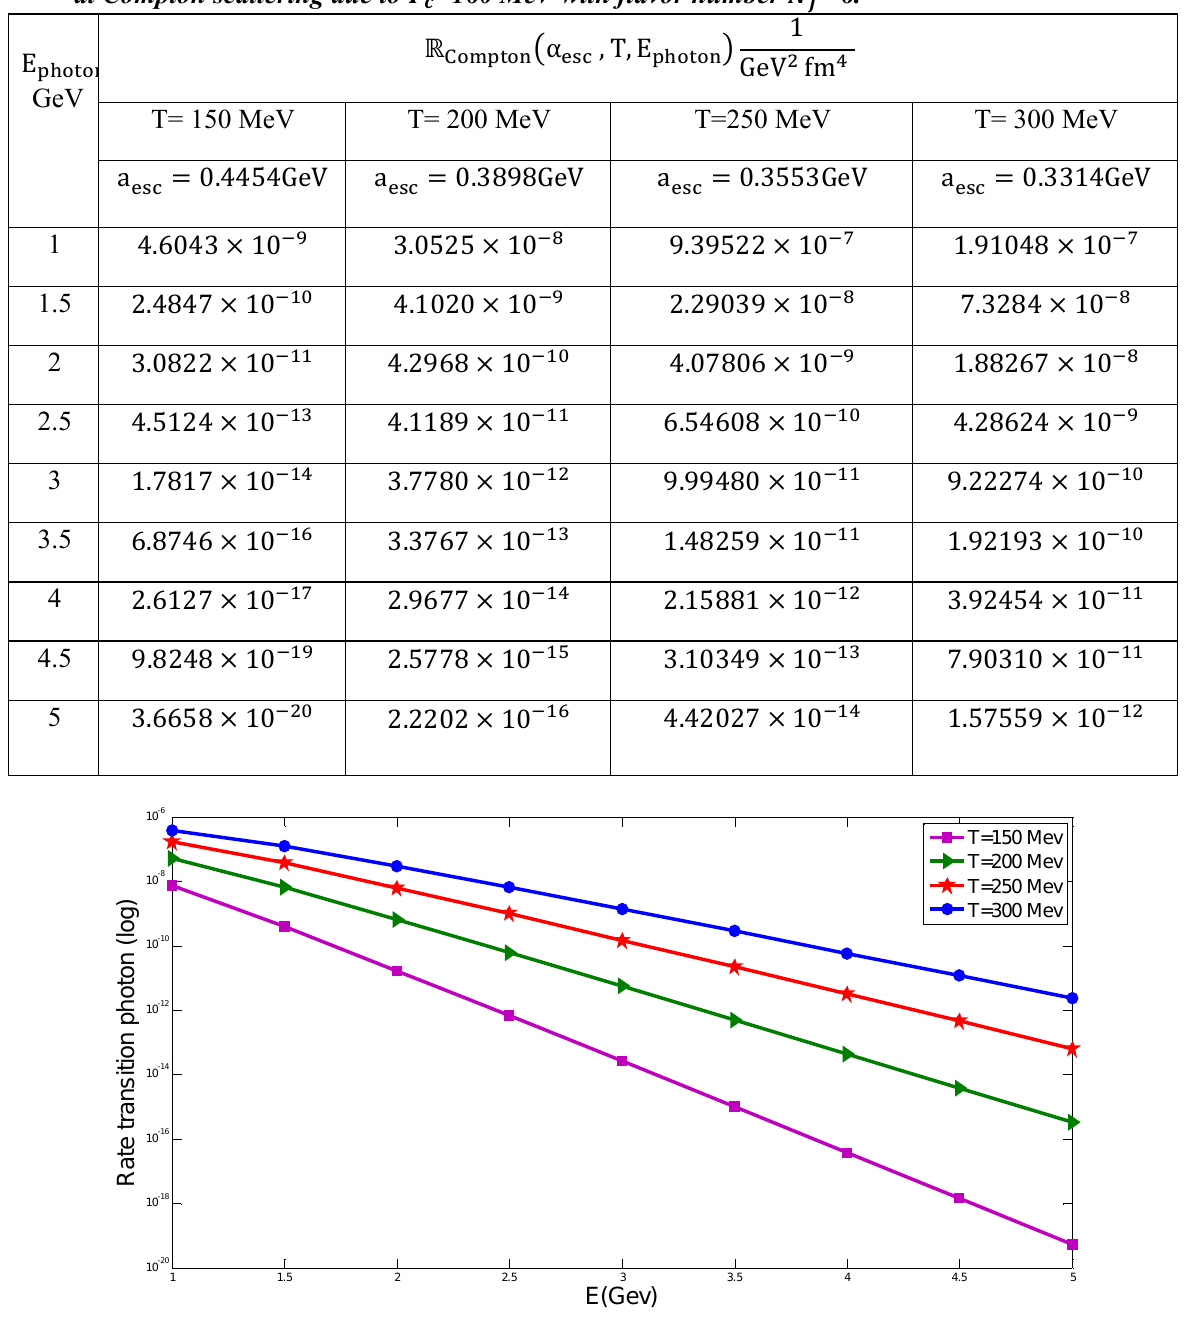
for (cid:2185)(cid:2189) → (cid:2186)(cid:2237) system (cid:2172)(cid:2190)(cid:2197)(cid:2202)